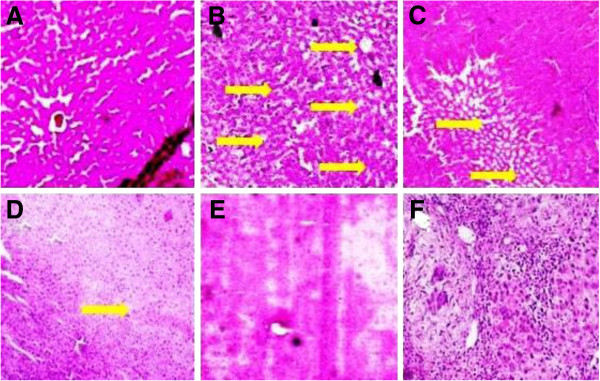
Effect of Melastoma malabathricum Linn. (MM) on liver fat accumulation in different groups of rats: (A) Normal control: (B) Diabetic control: Diabetic control histopathology of rat liver shown the micro fat droplet deposition (yellow arrow) (C) MM I (100 mg/kg): Tested drug histopathology shown granularity and quantity of fat droplet (yellow arrow) were much less compared to the diabetic control. (D) MM II (250 mg/kg): Tested drug histopathology there was only few micro fat droplet was present (yellow arrow). (E) MM III (500 mg/kg): The amount of tested drug increased and the histopathology similar to the glibenclamide treated group. (F) Glibenclamide (10 mg/kg): Standard drug treated group shown histopathology similar to the normal control groups. The samples were obtained from the same liver anatomical regions. For each group, 6 rats were examined and 50 pictures were taken. The above picture for each group was chosen randomly from the 80 pictures in this group. Original magnification, 10 ×.